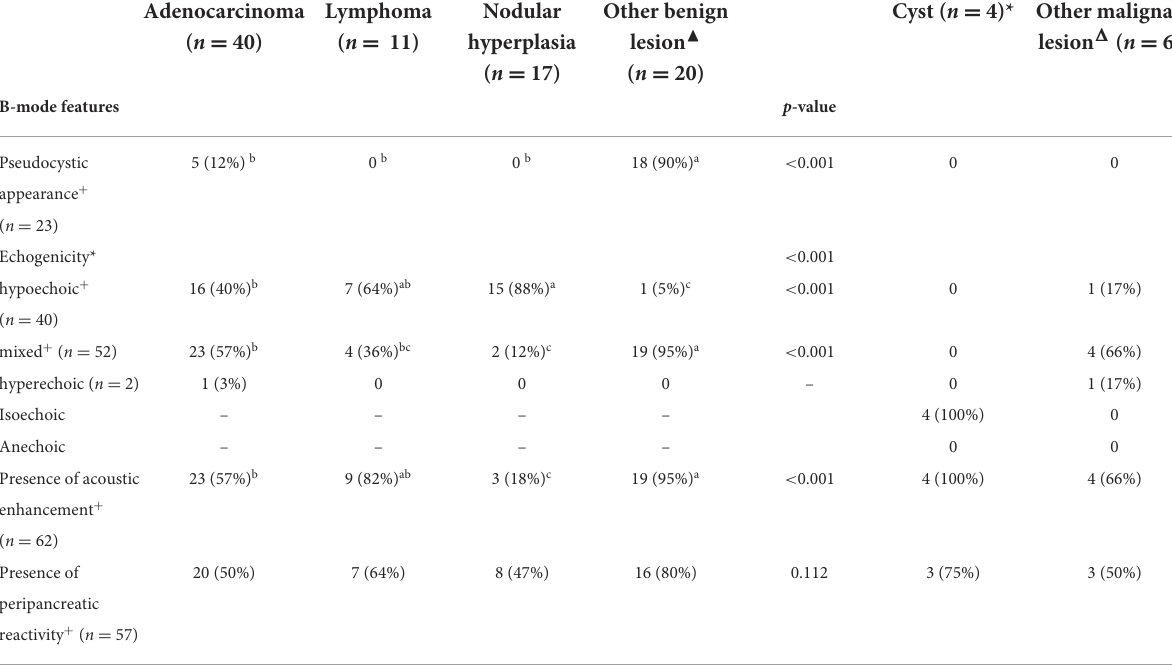
TABLE 1 Qualitative and quantitative B-mode features of the lesions, along with cytopathological classification. Adenocarcinoma Lymphoma Nodular Other ( n = 40) ( n = 11) hyperplasia